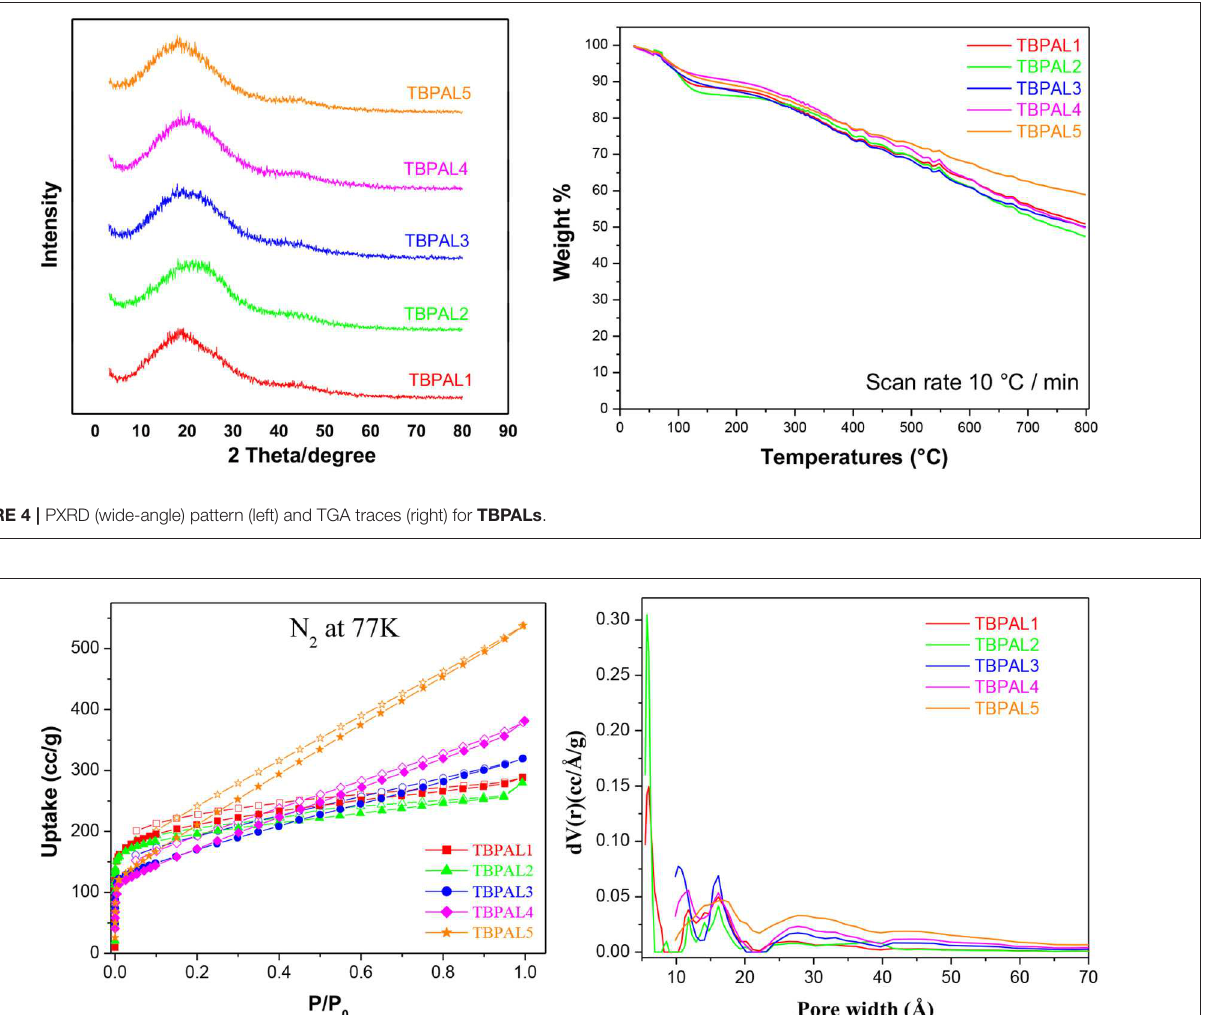
FIGURE 5 | N 2 adsorption–desorption isotherm at 77K (left) and pore size distribution (right) of TBPALs .